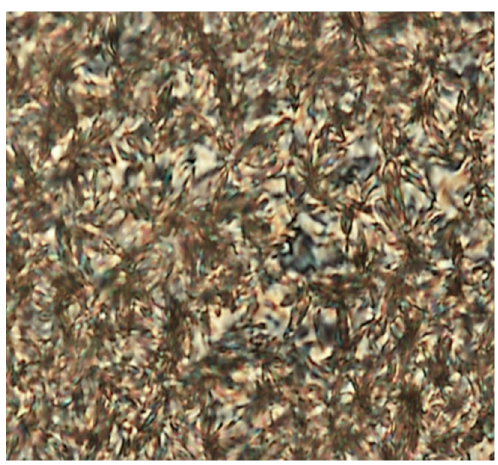
Figure 4. Optical micrograph of cured K–LCE/BN composites.